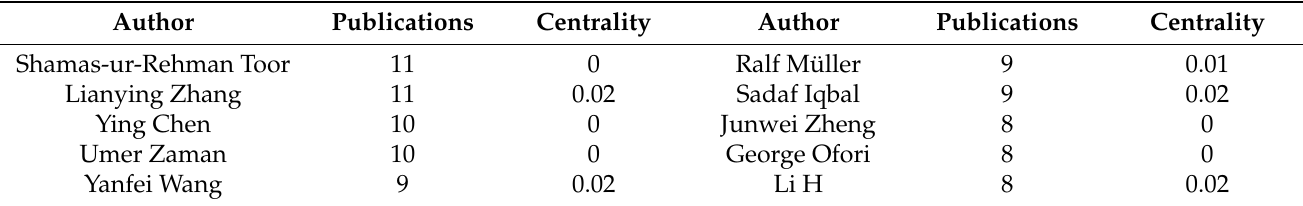
Table 3. Top 10 authors based on the number of